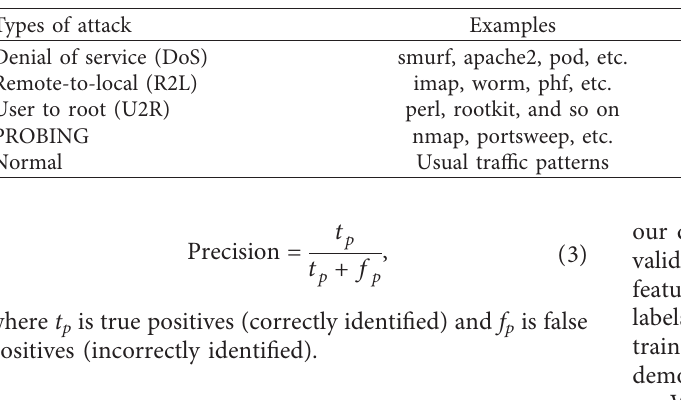
Table 1: Types of attack in the